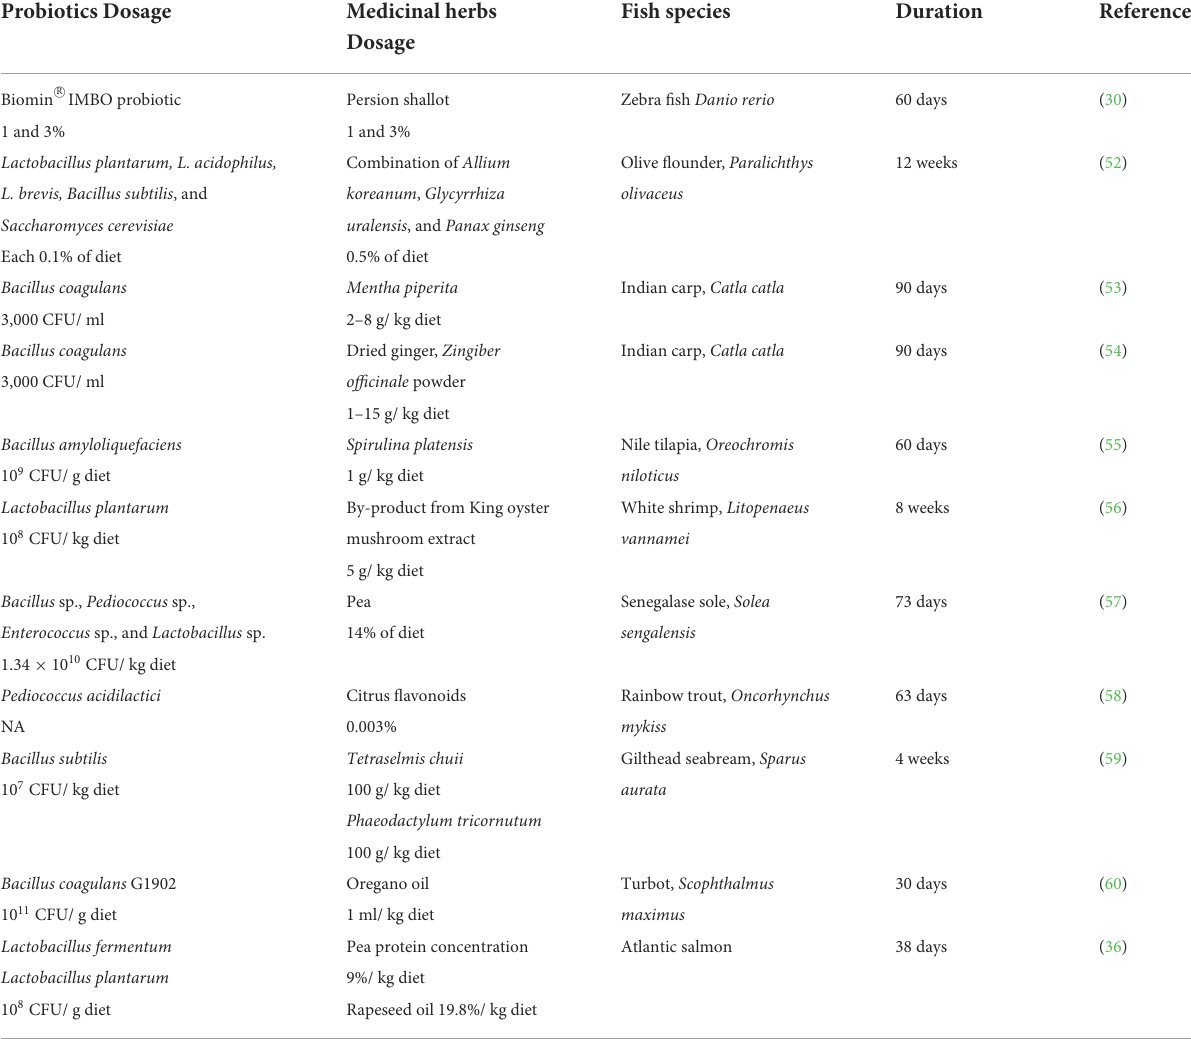
TABLE 2 Application of probiotic and medicinal herb combination in improving growth performance of aquatic animals. Probiotics